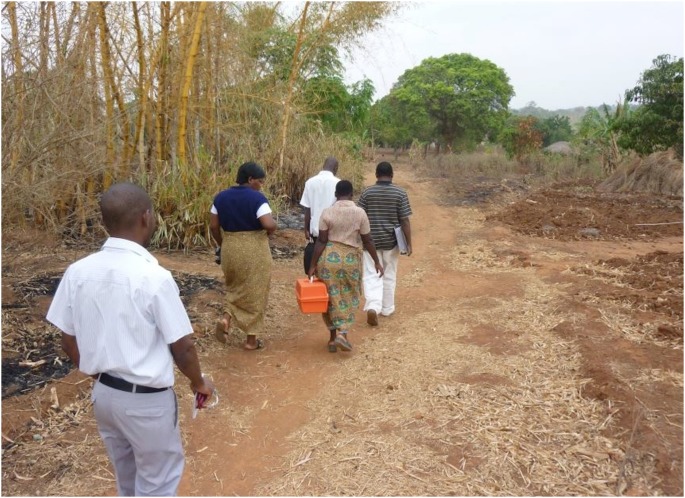
Neno Palliative Care Program team members conduct a home visit in a rural village.Five members of the Neno Palliative Care Program (NPCP) team travel by foot to reach the home of a palliative care patient living in rural Neno district, Malawi. An Abwenzi Pa Za Umoyo/Partners In Health Medical Officer with specialized training in palliative care (foreground) leads the home visit. He is accompanied by (from left to right) a palliative care nurse, a Program on Social and Economic Rights social worker, a Village Health Worker and a NPCP clerk. NPCP team members work together to assess and treat patient pain and other physical symptoms, provide disease-specific care for serious chronic illnesses, and offer psychosocial support to patients and their families.